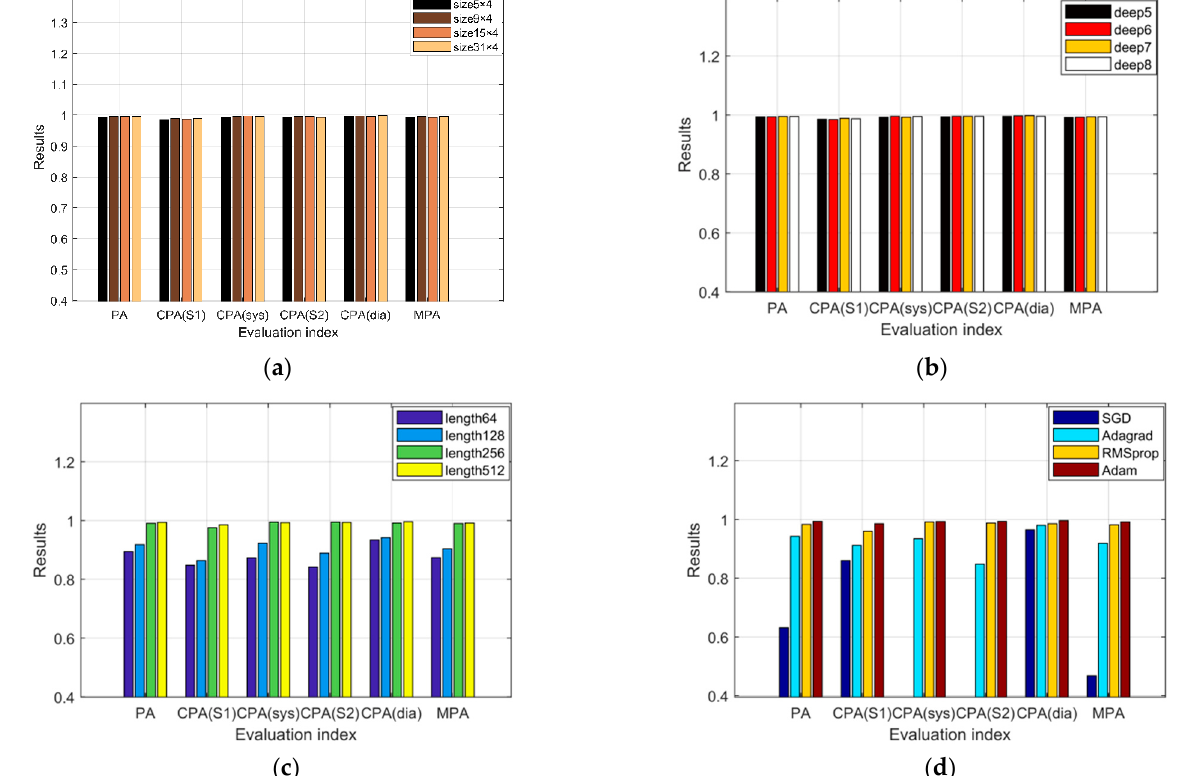
Figure 10. Experimental results under different parameters: ( a ) Results under different fixed lengths; ( b ) Results under different optimizers; ( c ) Results under different network depths; ( d ) Results under different convolution kernel sizes.